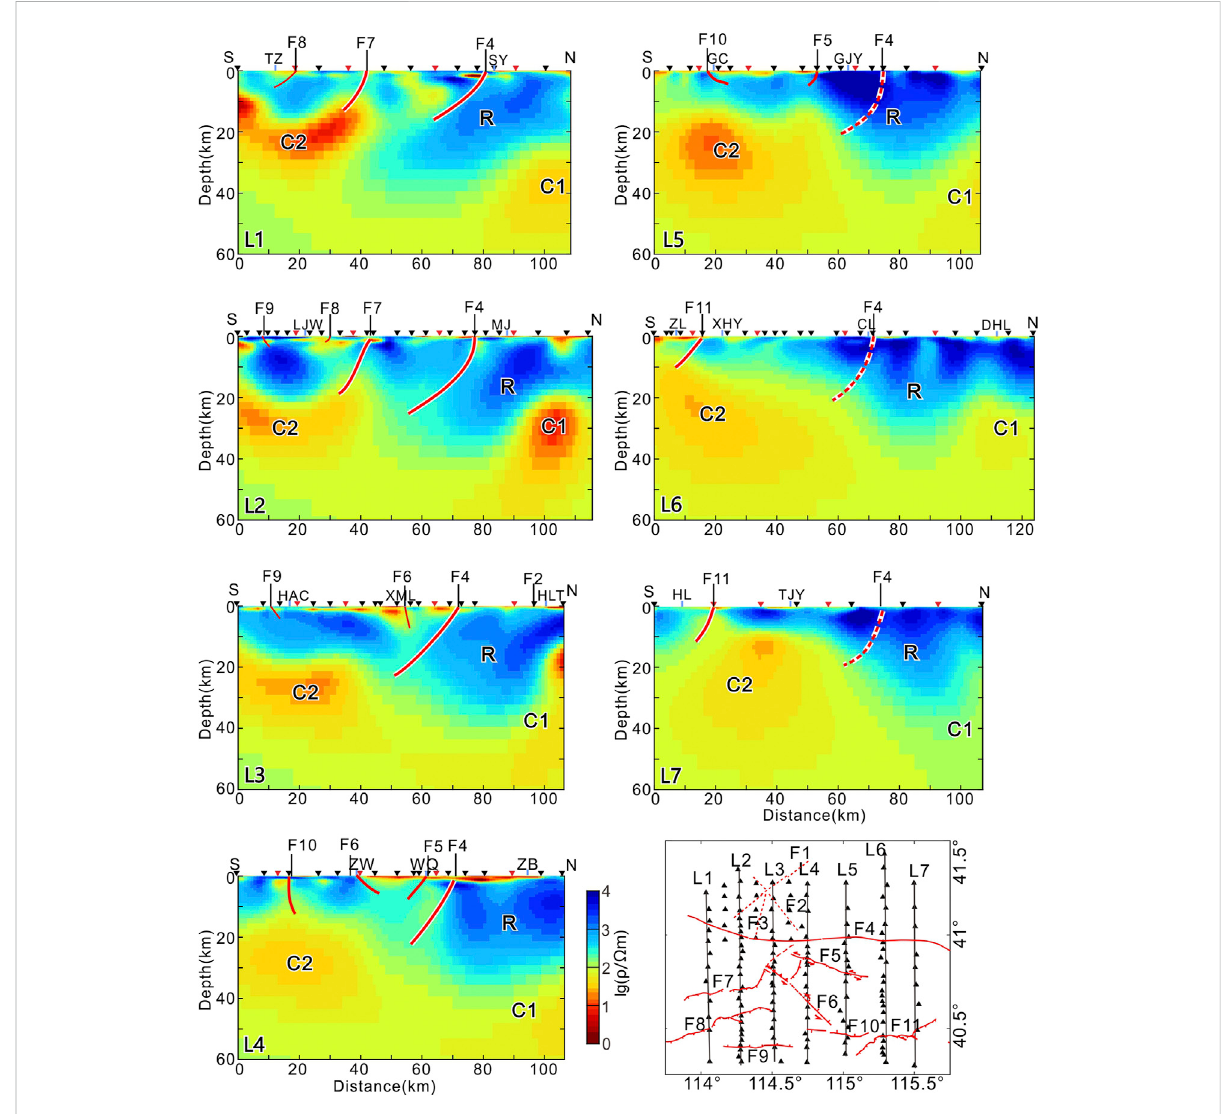
FIGURE 8 Cross sections of seven pro fi les (L1, L2, L3, L4, L5, L6, and L7) extracted from the 3D inversion model.